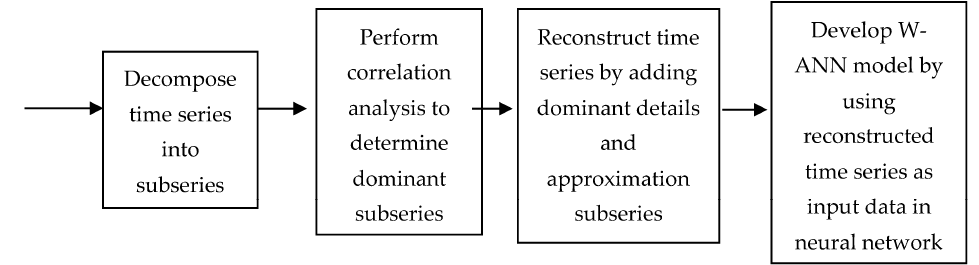
Figure 2. Schematic diagram of wavelet ‐ based artificial neural network (W ‐ ANN) model development.